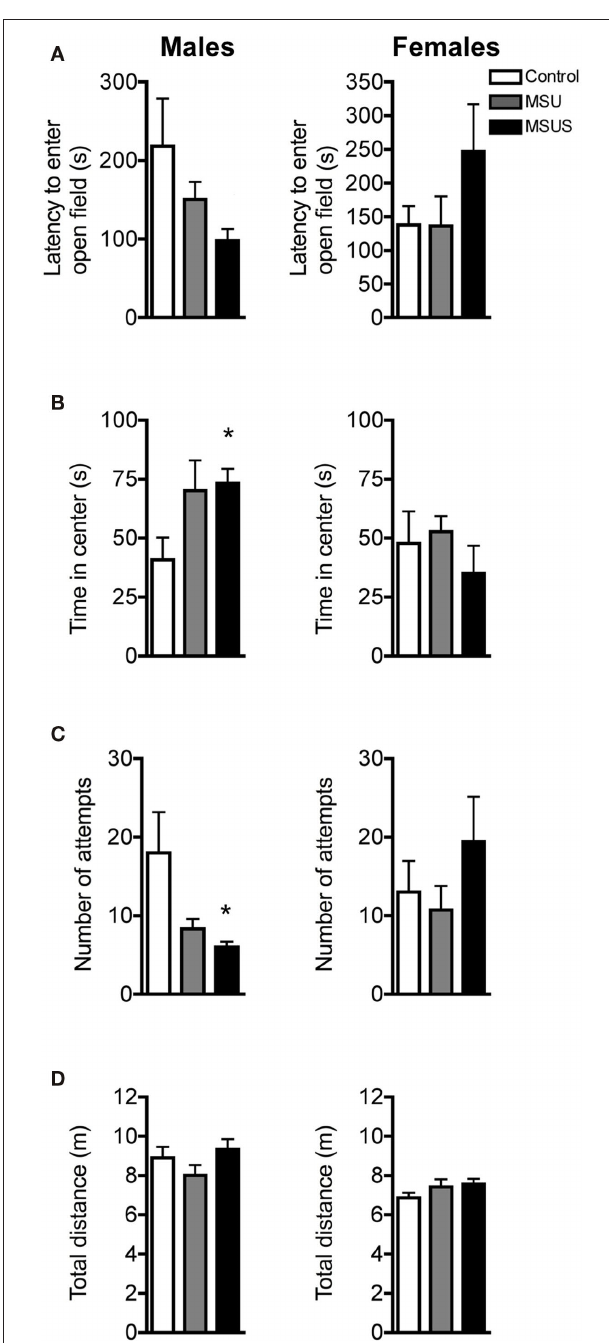
FigUrE 3 | Behavior in F 1 control, MSU, and MSUS mice in the open field emergence test. (A) F 1 MSU and MSUS males had a graded decrease in latency to first enter the open field (left), but F 1 MSU and MSUS females had a latency comparable to control mice (right). (B) F 1 MSUS males spent more time in the center of the open field (left) but not MSU or MSUS females (right). (C) F 1 MSUS males made fewer attempts to enter the open field (left) but not MSU or MSUS females (right). (D) F 1 MSU and MSUS males and females covered similar distances in an open field. Males: MSU, n = 6, MSUS, n = 8, control, n = 8; females: MSU, n = 7, MSUS, n = 7, control, n = 6. * p < 0.05. Bar graphs represent mean values ± SEM.